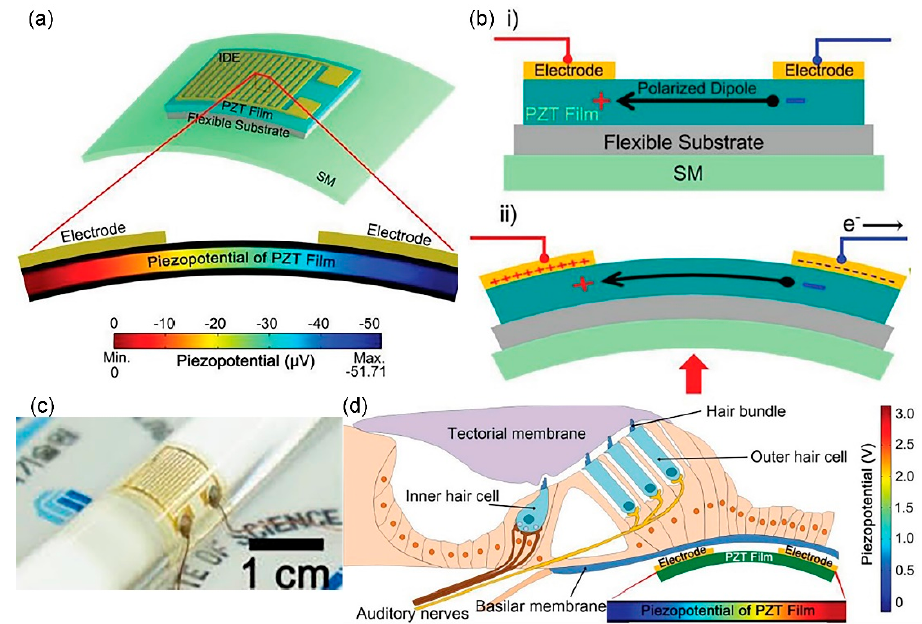
Figure 10. ( a ) Gold IDEs patterned on the flexible PZT film and the simulated potential distribution in PZT film between the adjacent electrodes. ( b ) The principle operation of piezoelectricity generation in iPANS device (i) before and (ii) after bending deformation. ( c ) The attachment of an iPANS device on a 1 cm curvature radius of glass rod. ( d ) The conceptual schematic of flexible iPANS device insertion under BM in a mammalian cochlea. The upward bending at 600 nm due to sound wave vibration generates 3 V of piezoelectric potential [69].